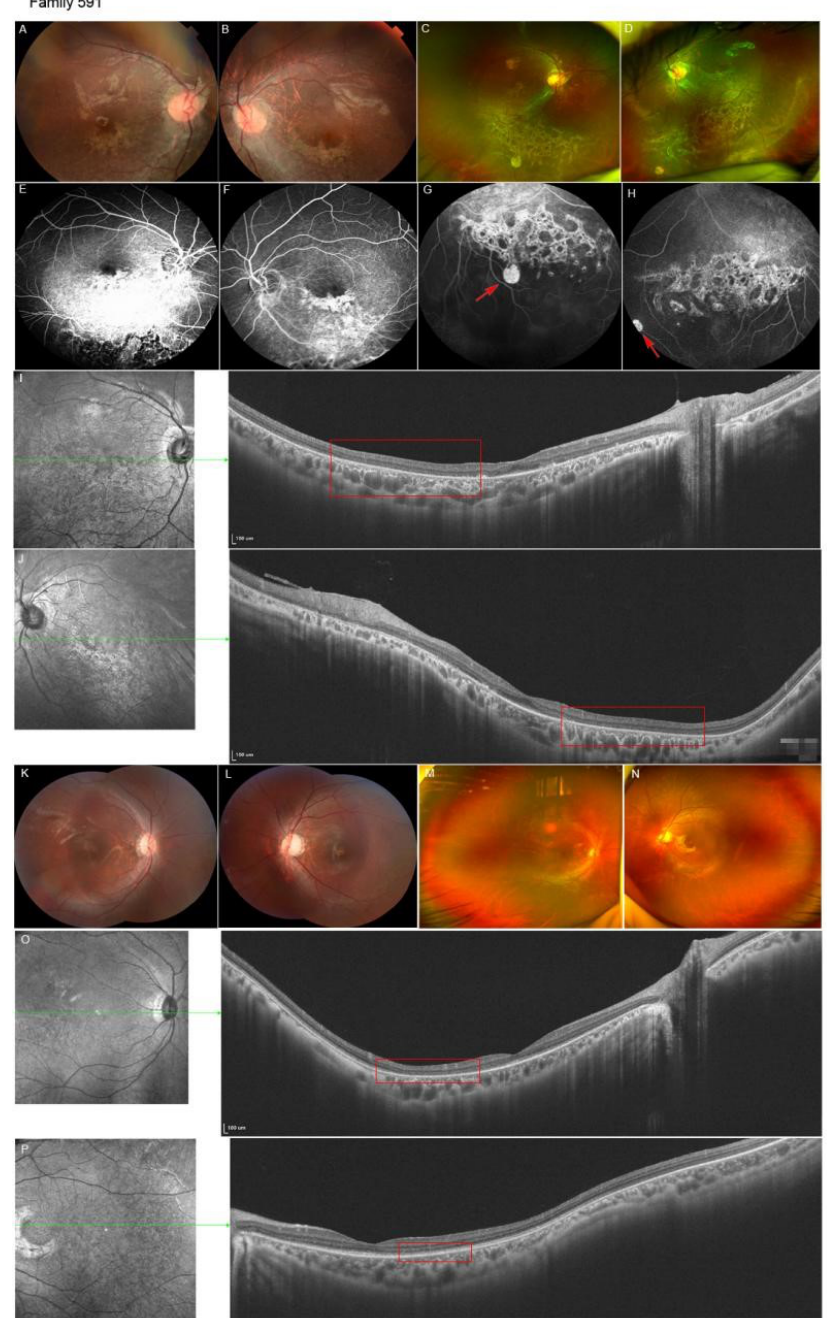
Figure 1. The c.1915dupA was detected in an eight-year-old boy and his younger brother. Ocular materials of proband ( A – J ): The fundus photograph showed symmetric inferior and para-optic chorioretinal dysplasia in both eyes, where the macula was involved ( A , B ). SLO showed isolated chorioretinal dysplasia unrelated to folds and paving-stone degeneration (red arrow) in both eyes ( C , D ). FFA revealed symmetric hyperfluorescence corresponding to lesions in both eyes ( E – H ). SS- OCT showed focus loss of the photoreceptor layers (red frame) in both eyes, the outer plexiform layer and outer nuclear layer in the macula were affected ( I , J ). Ocular material of his brother ( K – P ): Fundus imaging showed bilateral para-optic chorioretinal dysplasia and a pale optic disc in the left eye ( K , L ). SLO showed normal peripheral retina ( M , N ). SS-OCT showed a focus loss of photoreceptor layers (red frame) located in the temporal retina in both eyes ( O , P